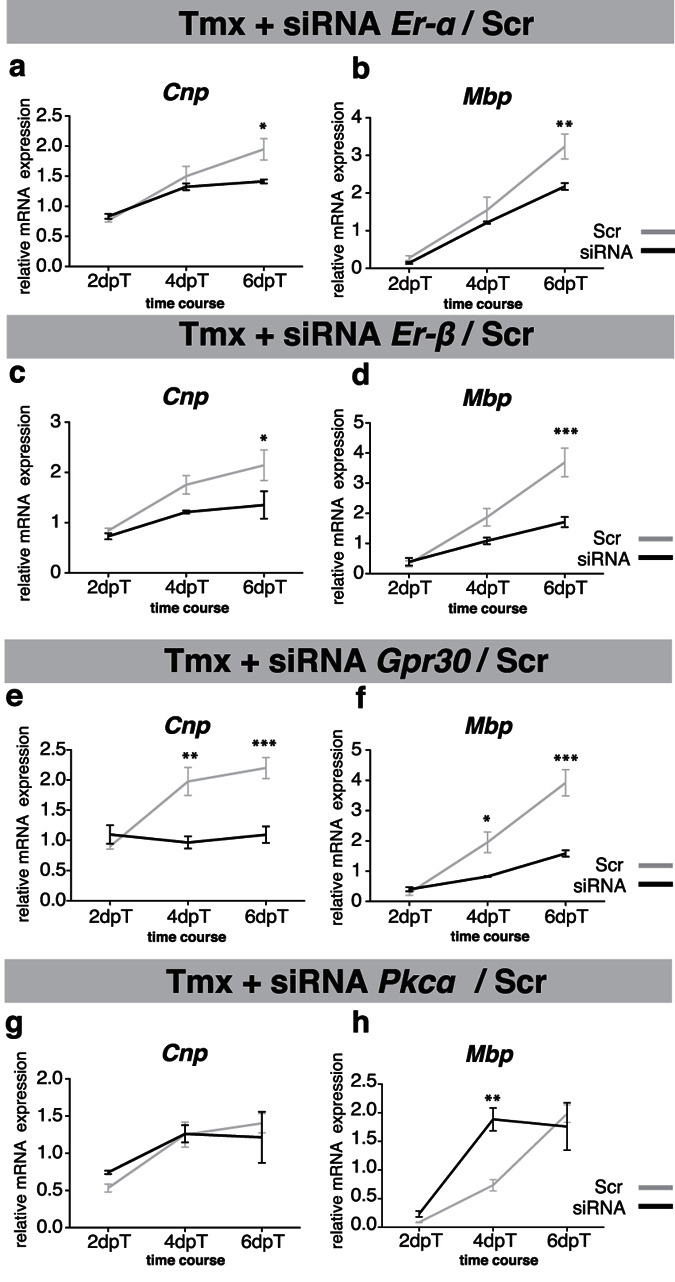
Tamoxifen-induced OPC differentiation depends on ERα, ERβ, and GPR30, but not PKCα signaling.(a–h) Line graphs demonstrating that tamoxifen-induced differentiation (+Tmx (50 nM)) of OPCs is impaired when cells are concomitantly transfected with siRNA targeting Er-α, Er-β, or Gpr30 as compared with control siRNA (scrambled, Scr, gray line). Gene silencing of Prkcα in addition to tamoxifen treatment resulted in transiently increased Mbp expression at day 4, demonstrating that tamoxifen-induced OPC differentiation is independent from PKCα (n = 3). One-way ANOVA with Bonferroni’s post-hoc tests: *p < 0.05, **p < 0.01, ***p < 0.001. Error bars: SEM.